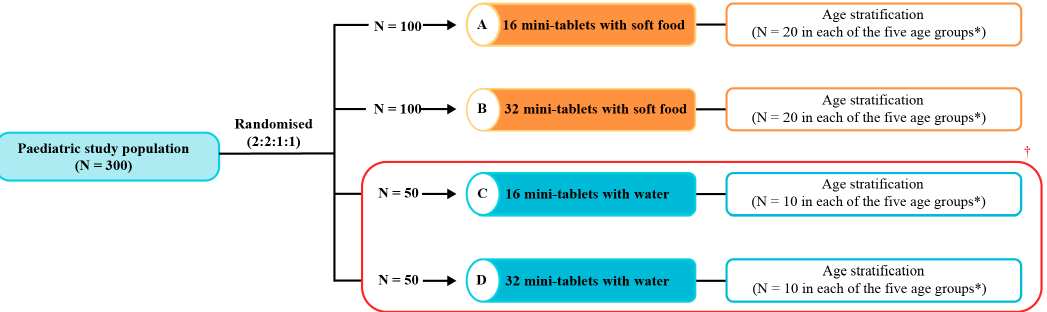
Figure 1. Image of the 3 mm diameter, 2 mm thickness placebo mini-tablets (Excella, Feucht, Germany).